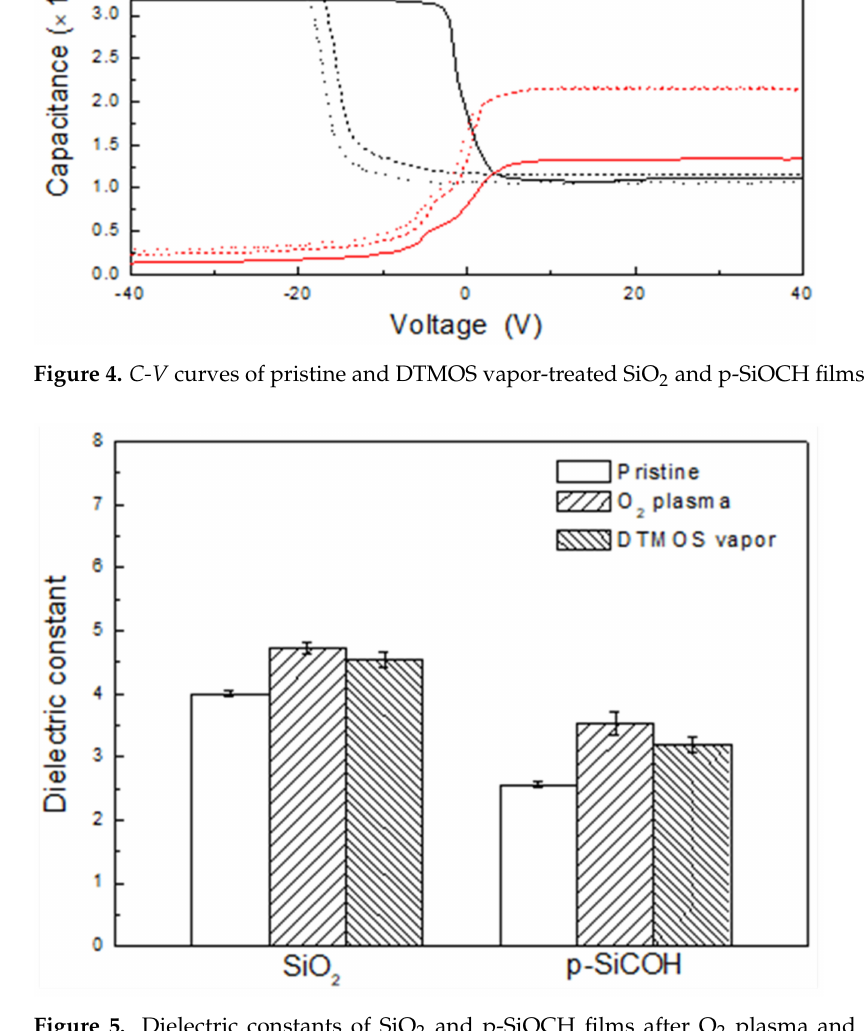
Figure 5. Dielectric constants of SiO 2 and p-SiOCH films after O 2 plasma and DTMOS vapor